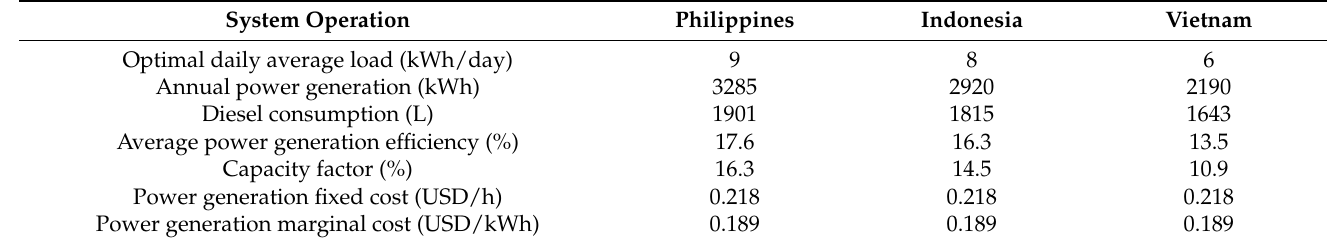
Table 10. Comparison of Base 1 system performance (based on the optimal daily average load in the three countries).